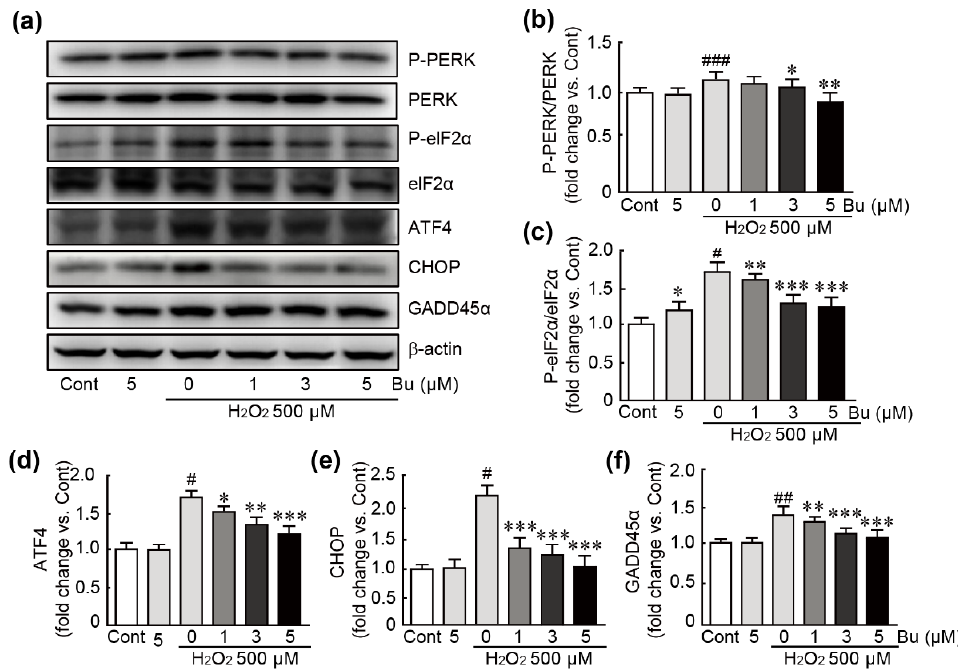
Figure 6. Butein suppresses ER stress in oxidative-stress-induced H9c2 cardiomyoblasts. ( a ) Western blot analysis for the expression levels of ER stress-related proteins including PERK, eIF2 α , ATF4, CHOP, GADD45 α , and β -actin (loading control) using cells treated with butein and/or H 2 O 2 . The band densities of the ratio of phospho-PERK/total PERK ( b ), ratio of phopho-eIF2 α /total eIF2 α ( c ), ATF4 ( d ), CHOP ( e ), and GADD45 α ( f ) proteins were calculated with HD imaging software. The results are shown as the mean ± SEM in triplicate. # p < 0.05, ## p < 0.01, and ### p < 0.001 vs. control group. * p < 0.05, ** p < 0.01, and *** p < 0.001 vs. H 2 O 2 -only group. Cont; control, Bu; butein.